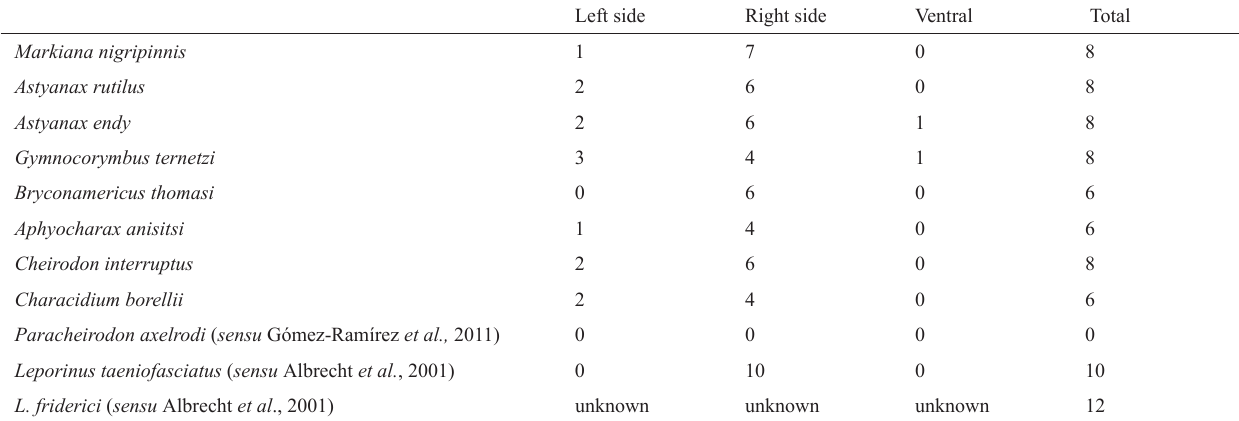
Table 1. Intestinal caeca in Characidae.